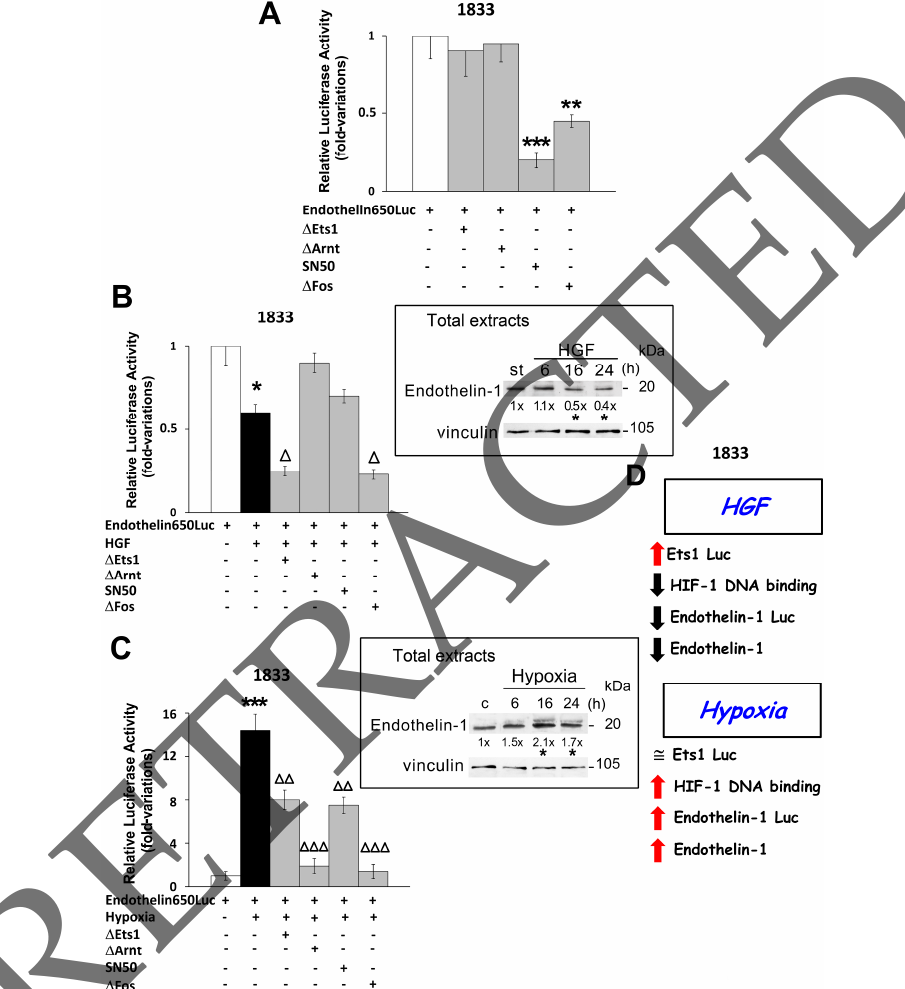
with anti-HIF-1 α antibody was performed. B23 was used for normalization. The experiments were repeated three times. The numbers at the bottom indicate the fold variations versus control value, and the histogram shows the data as the means ± S.E. *** p < 0.001 versus control value. ( E ) Nuclear protein extracts, prepared from 1833 cells exposed to hypoxia, were used for gel-shift assay with the oligonucleotide containing the consensus sequence for HIF-1 or ARNT. Specific (sp) competition was performed; super-gel shift was carried out using anti-HIF-1 α antibody (Ab) and the nuclear protein extracts from 8-h hypoxia exposed cells. The experiments were repeated three times. Int. J. Mol. Sci. 2018 , 19 , 258